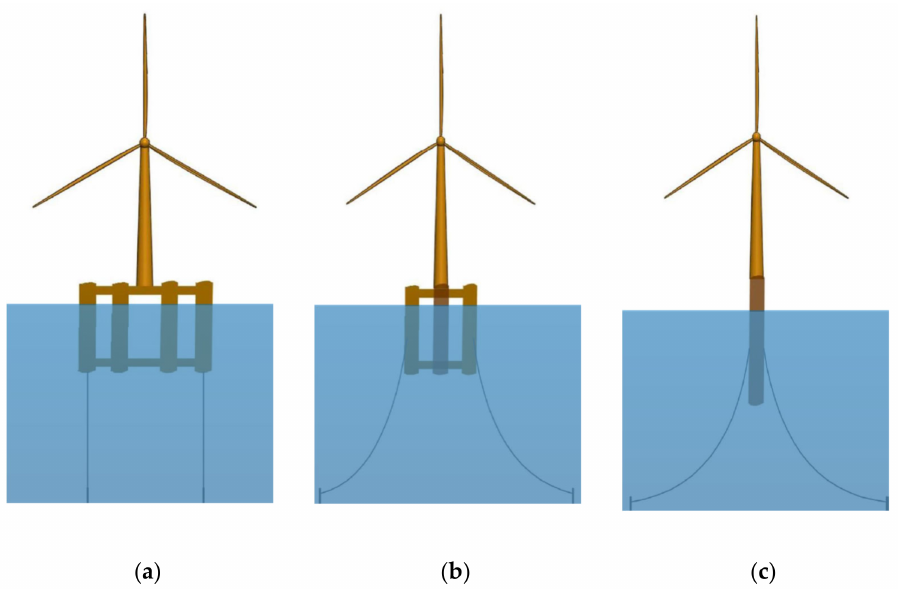
Figure 6. Floating wind turbine concepts: ( a ) tension leg; ( b ) semi-submersible; and ( c )